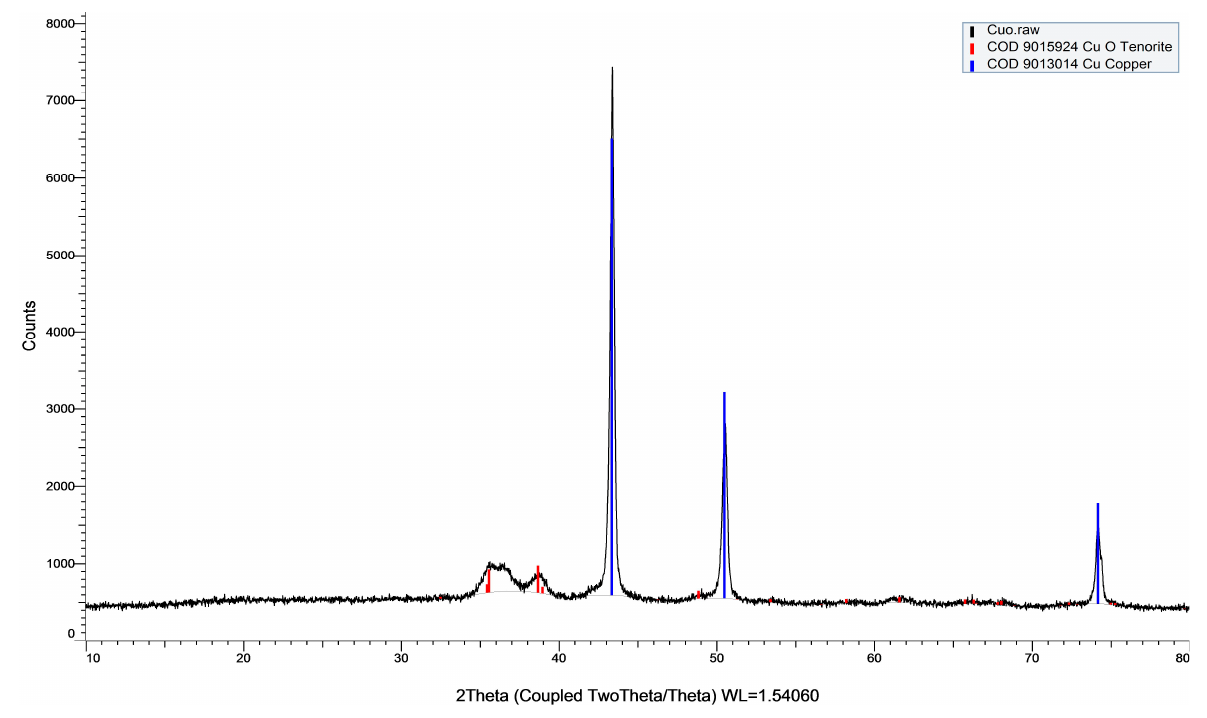
Figure 1. XRD pattern of Cu-NPs.